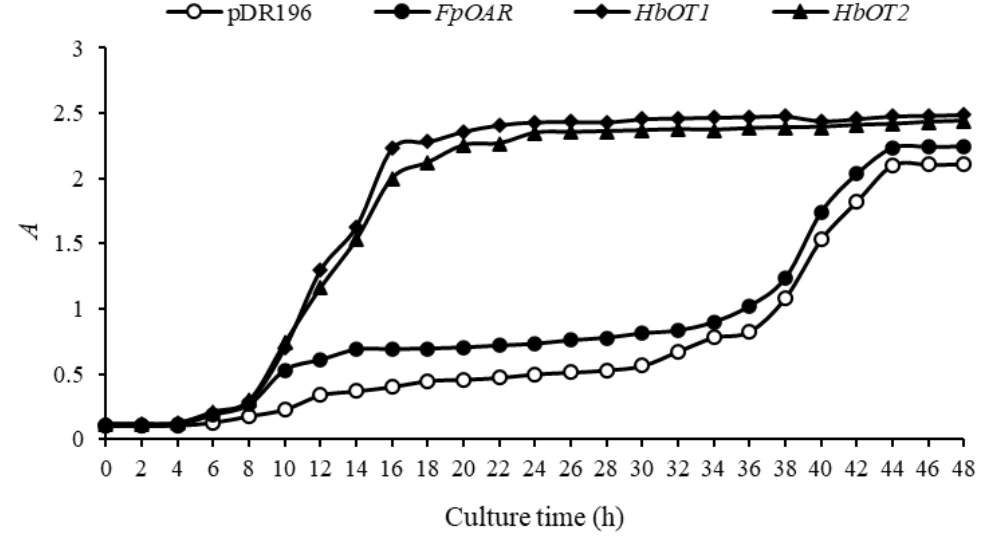
Figure 9. The growth curve of different yeast transformants under 2.7 mmol/L Al 3+ stress.